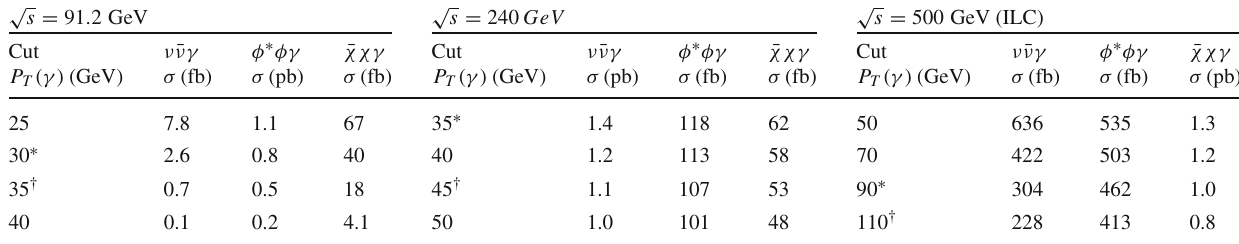
Table 1 Cross sections of SM background and signal processes at √ s = 91 . 2 and 240GeV CEPC. Here we also list the ILC runs’ result for the convenience of comparison. Photon pseudora- pidity restrict to the central region, | η | < 3 at CEPC and polar angle